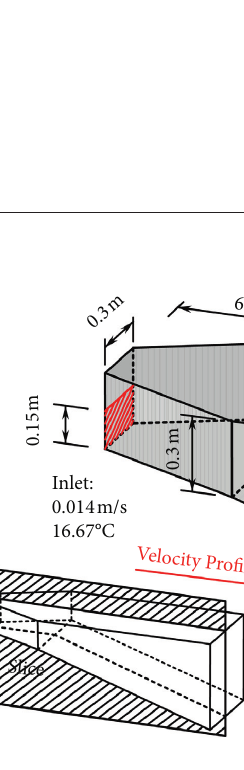
Figure 6: General layout of reservoir model.